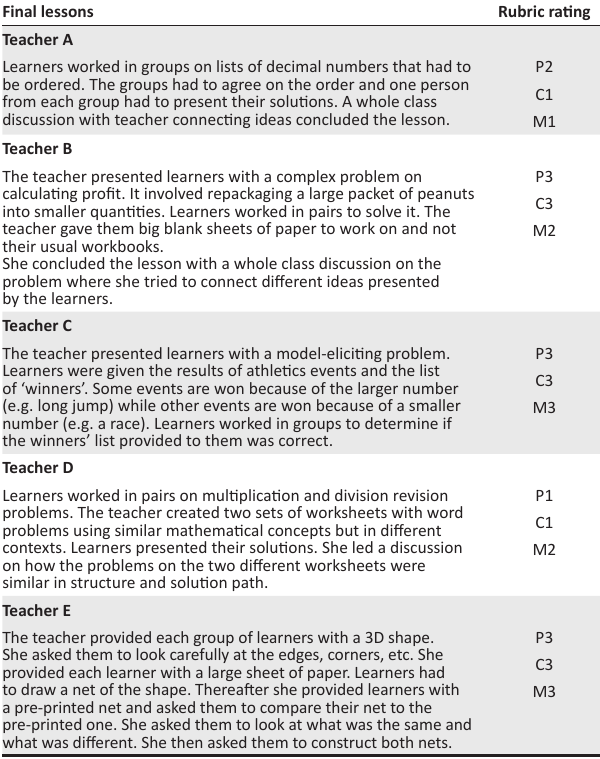
TABLE 4: Summary of final